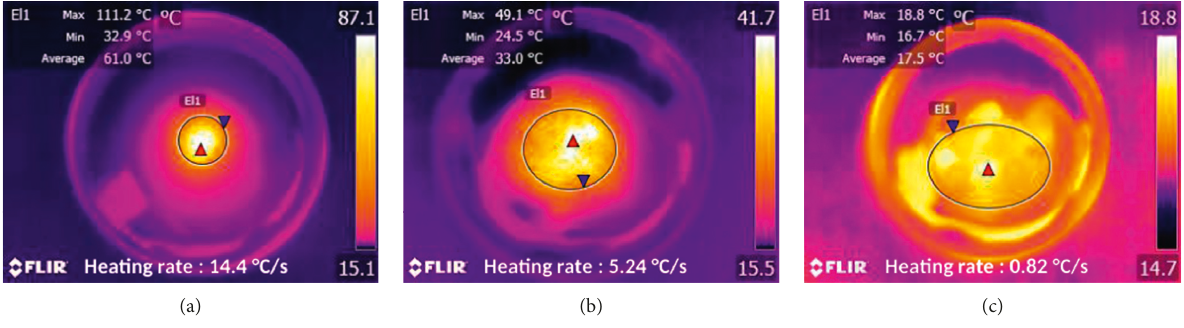
Figure 9: Infrared images of steel fiber (a), steel grit (b), and steel slag (c). Table 5: Main chemical elements and oxides of steel slag. Element (Wt.%)